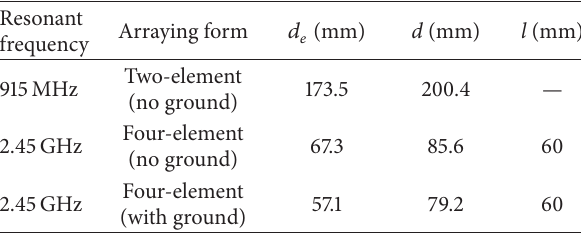
Table 2: Values of main parameters.